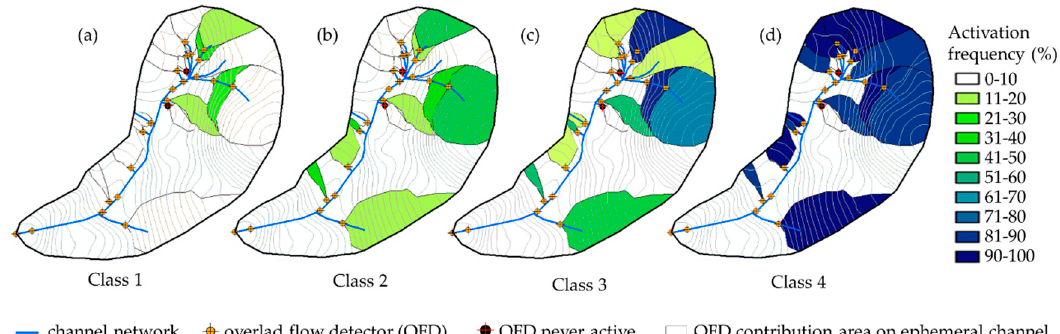
Figure 6. Frequency of activation of the contribution areas for each event class. ( a ) Class 1. ( b ) Class 2. ( c ) Class 3. ( d ) Class 4.